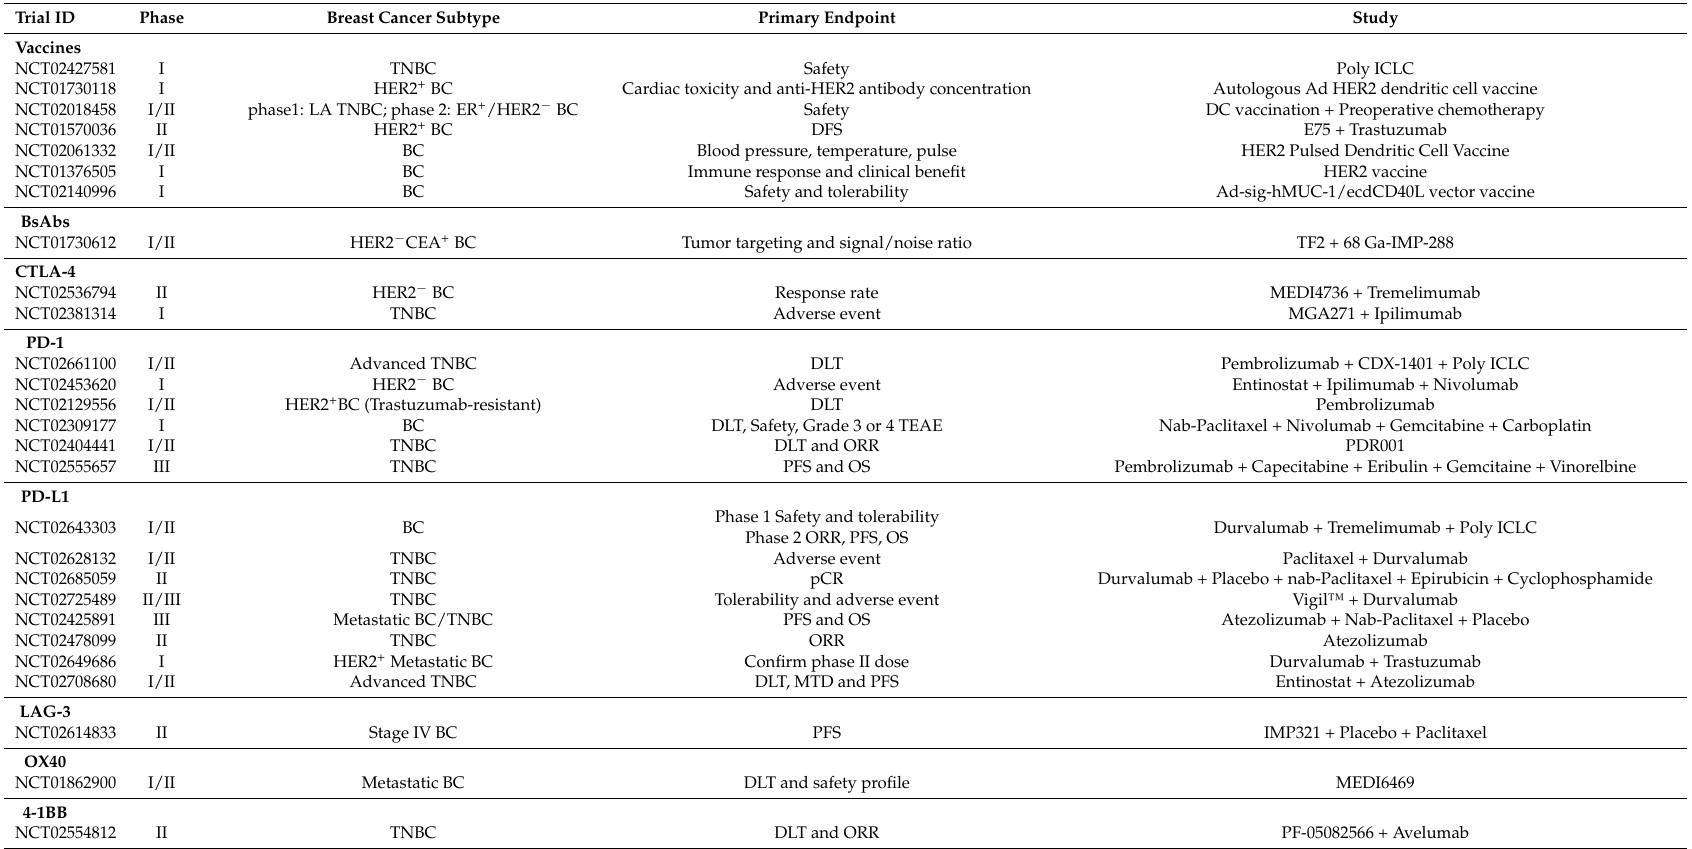
Table 1. Examples of ongoing clinical trial of immunotherapy in breast